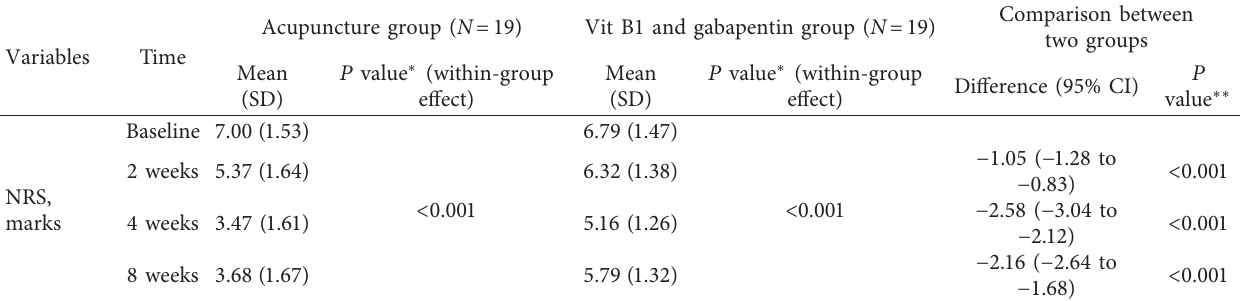
Table 2: Comparison of changes of NRS within and between groups over time.